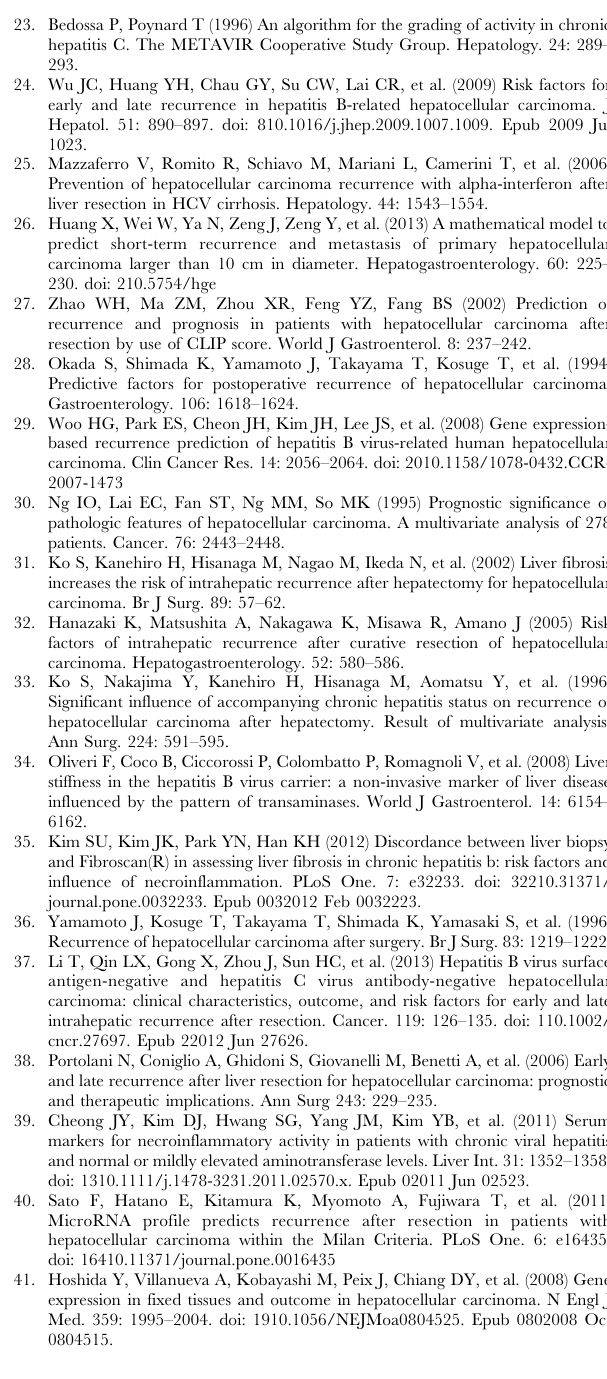
Table S1 Comparison between patients with and with- out late